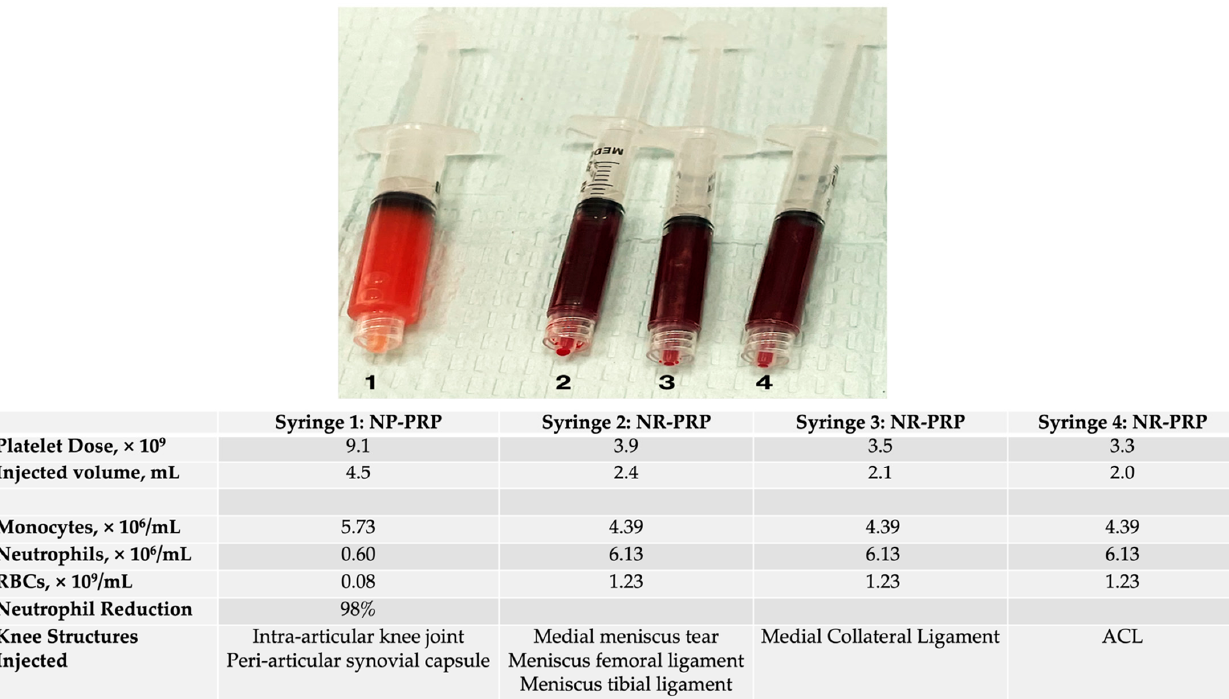
Figure 4. Description of Dosing and Bioformulations of the various injected Tissue Structures. Both, NP- and NR-PRP prepared volumes were transferred in smaller application syringes. The volumes in these syringes are corresponding with the calculations following the algorithm used, safeguarding platelet dose and bioformulations to treat the various tissue structures based of the pre-procedure treatment plan.